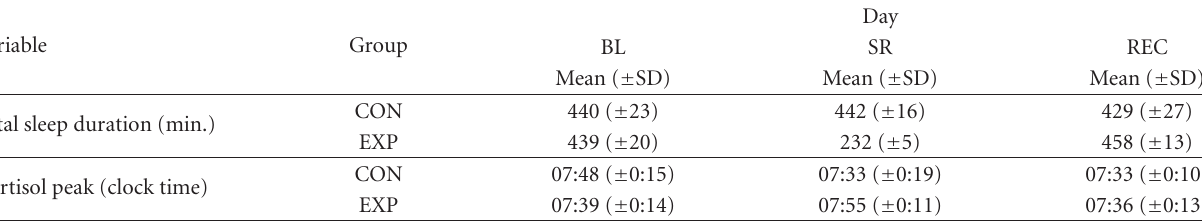
Table 1: Sleep duration and cortisol.